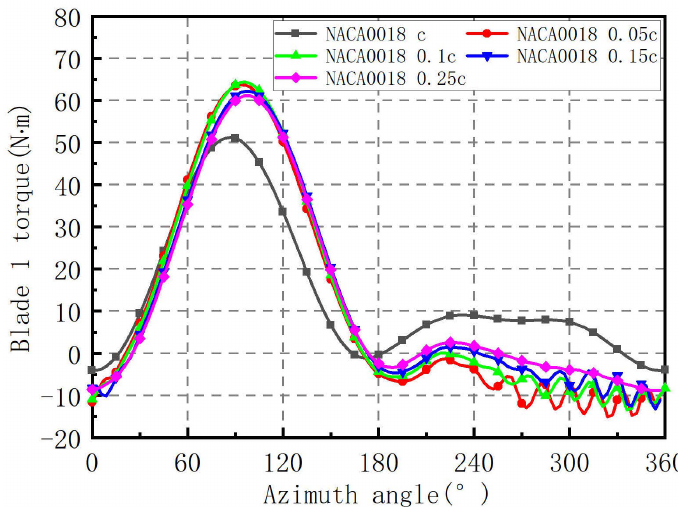
Figure 26. TSR = 2.96 instantaneous torque curve of J-shaped